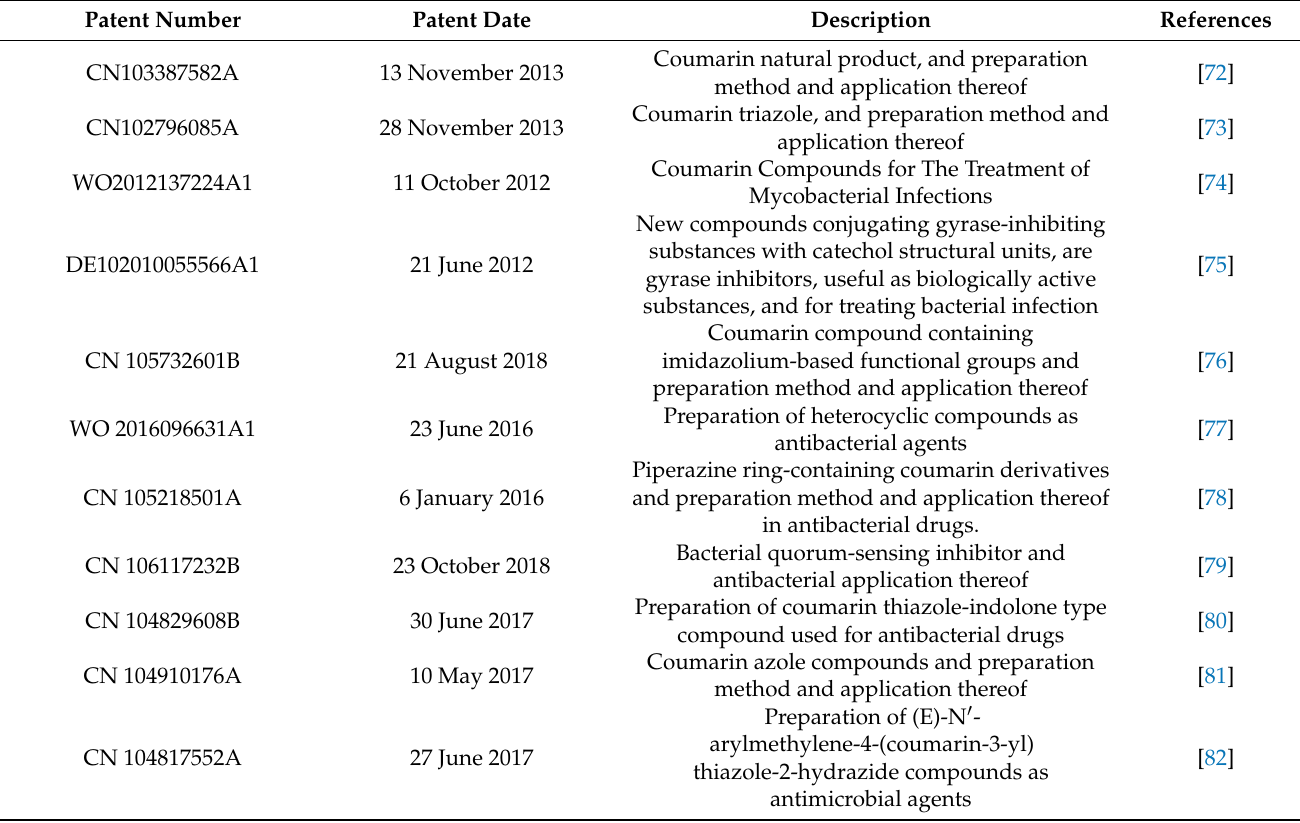
Table 1. Patents on coumarin analogues as antimicrobial Table 1 . Patents on coumarin analogues as antimicrobial agents.